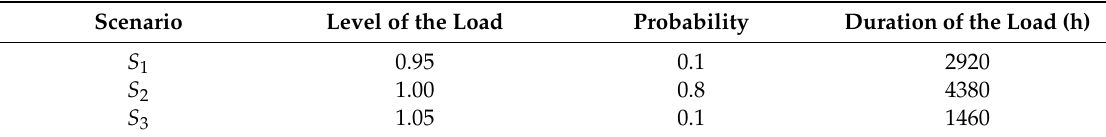
Table 9. The specifications of the system loading for probabilistic multi-objective RPP considering the load demand uncertainty.